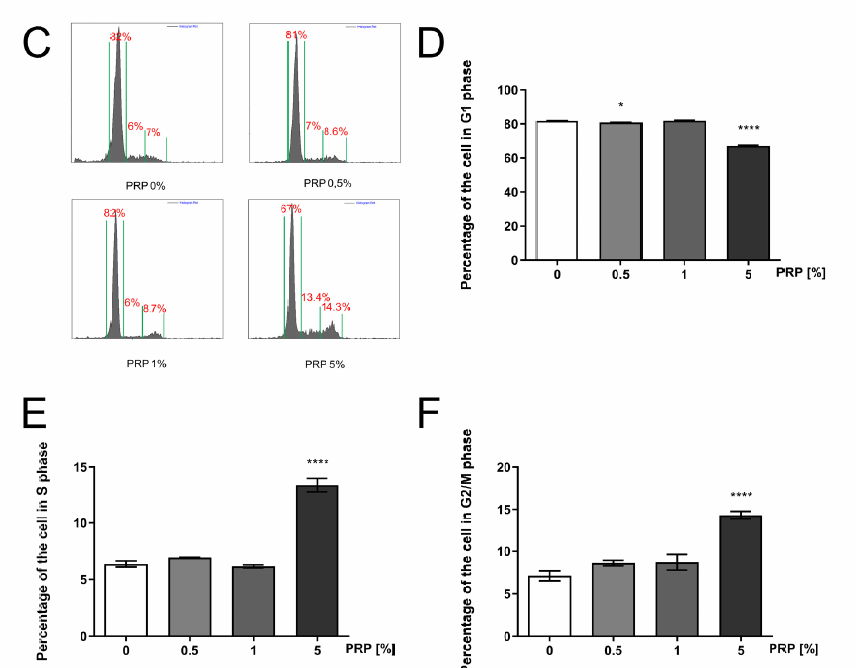
Figure 2. PRP-induced progression of the cell cycle of HaCaT keratinocytes ( A ) Expression of the selected cell-cycle regulatory proteins in PRP-treated keratinocytes; ( B ) Illustration of the cyclin- dependent cell cycle. Created with BioRender.com. ( C ) Ethanol-fixed cell cycle analysis of HaCaT cells after 24h incubation with PRP; ( D ) Percentage of keratinocytes in the G1 phase; ( E ) Percentage of keratinocytes in the S phase; ( F ) Percentage of keratinocytes in the G2/M phase. Statistical significances were expressed using asterisks such as * <0.05, and ****